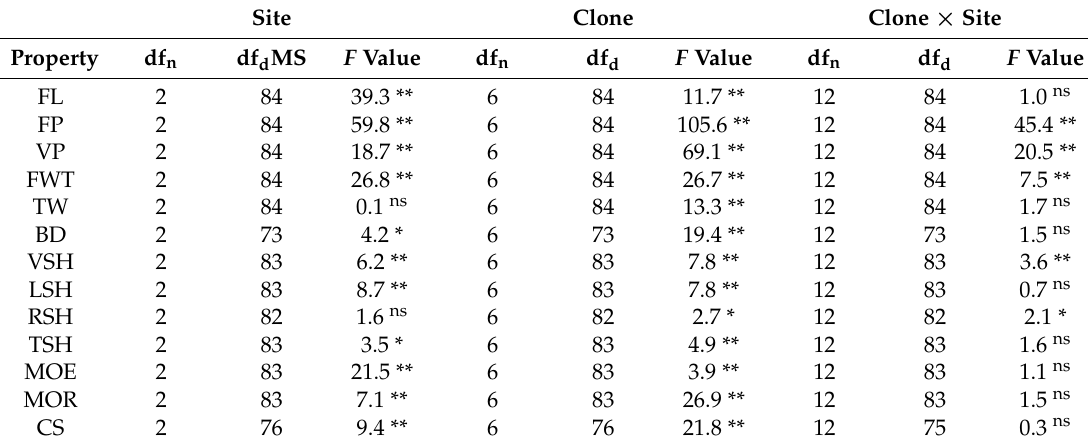
Table 4. Analysis of variance on selected wood properties of hybrid